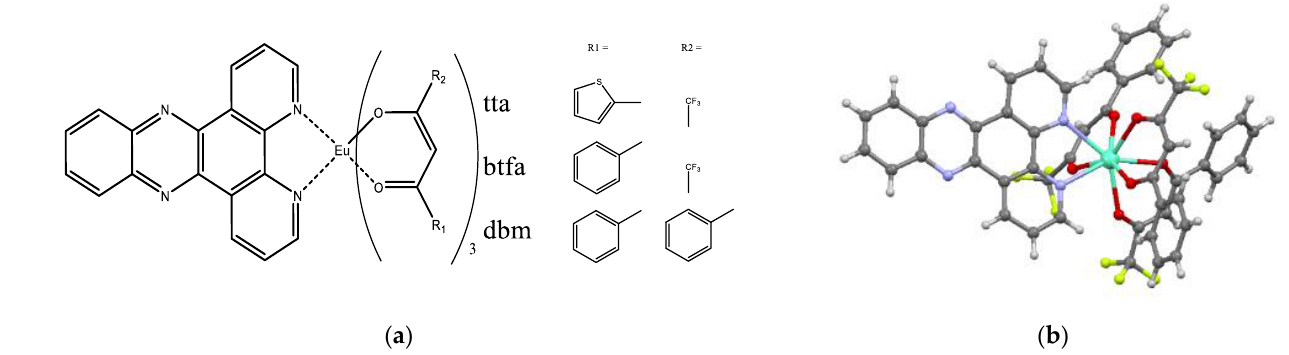
Figure 1. ( a ) Complexes Eu(dik) 3 DPPZ used in the present study. ( b ) The structure of [Eu(btfa) 3 DPPZ] in crystal.